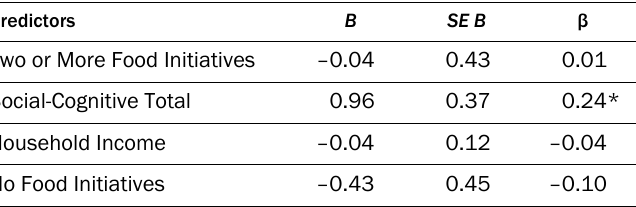
Table 6. Predictors of Fruit and Vegetable Intake